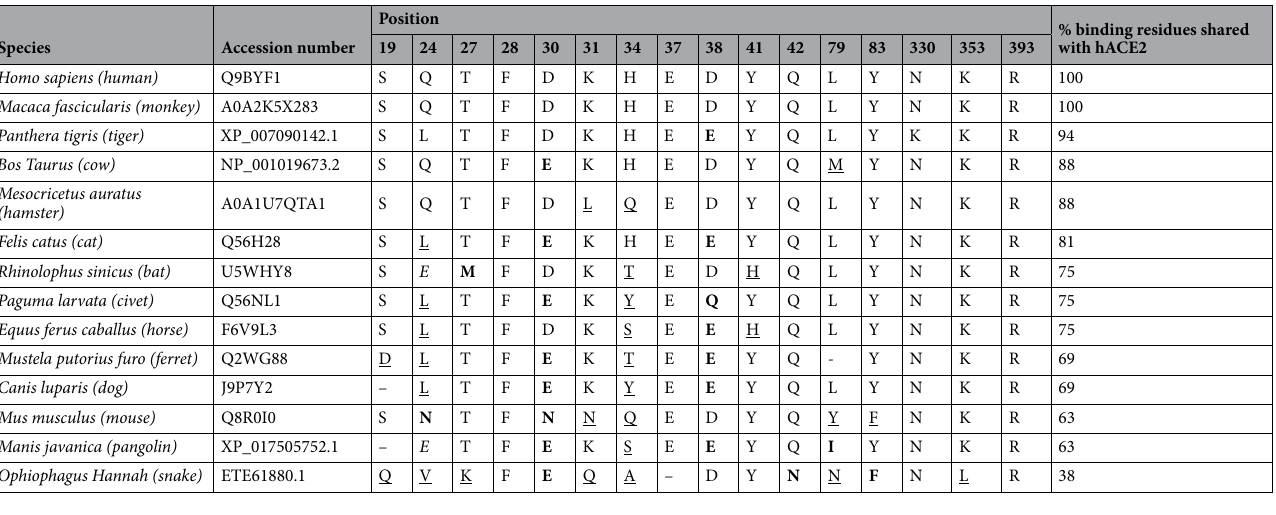
Table 1. ACE2 RBD residues interacting with the S protein RBD from MD simulations of complexes. Residues interacting with the same S residue in different species ACE2, that differ from those in human ACE2, are in bold (conservative replacements), in italics (partially conservative replacements) or in underline (non- conservative